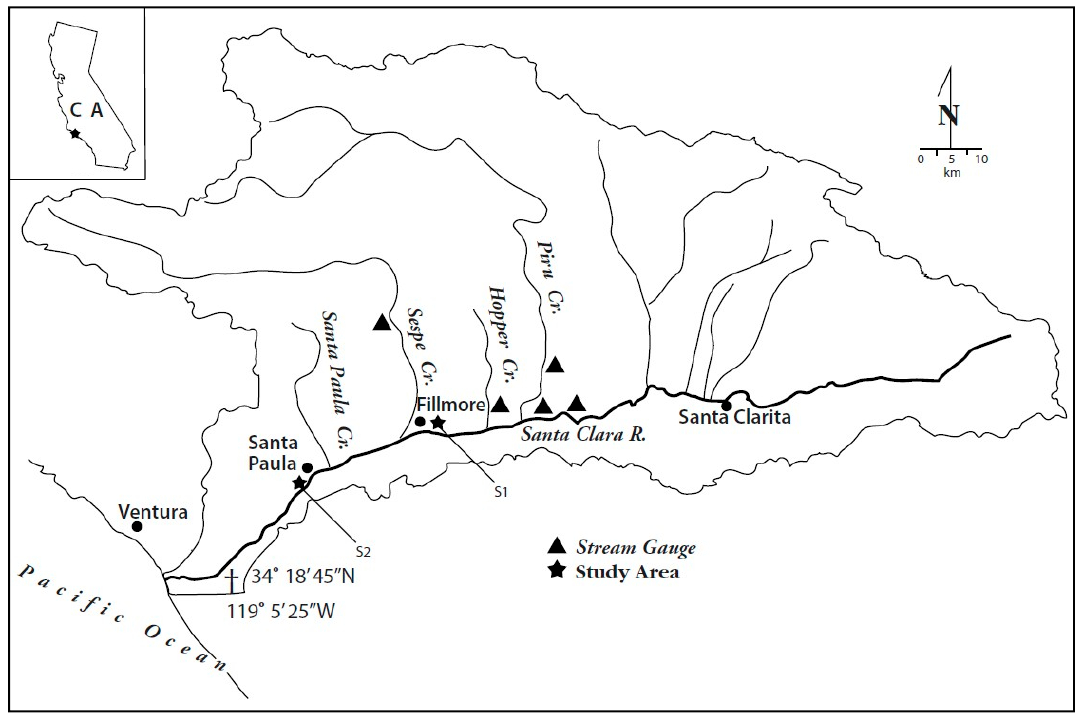
Figure 1. Map of the Santa Clara River drainage basin showing the location of study sites (S1 and S2) and stream gauging stations used in this study.